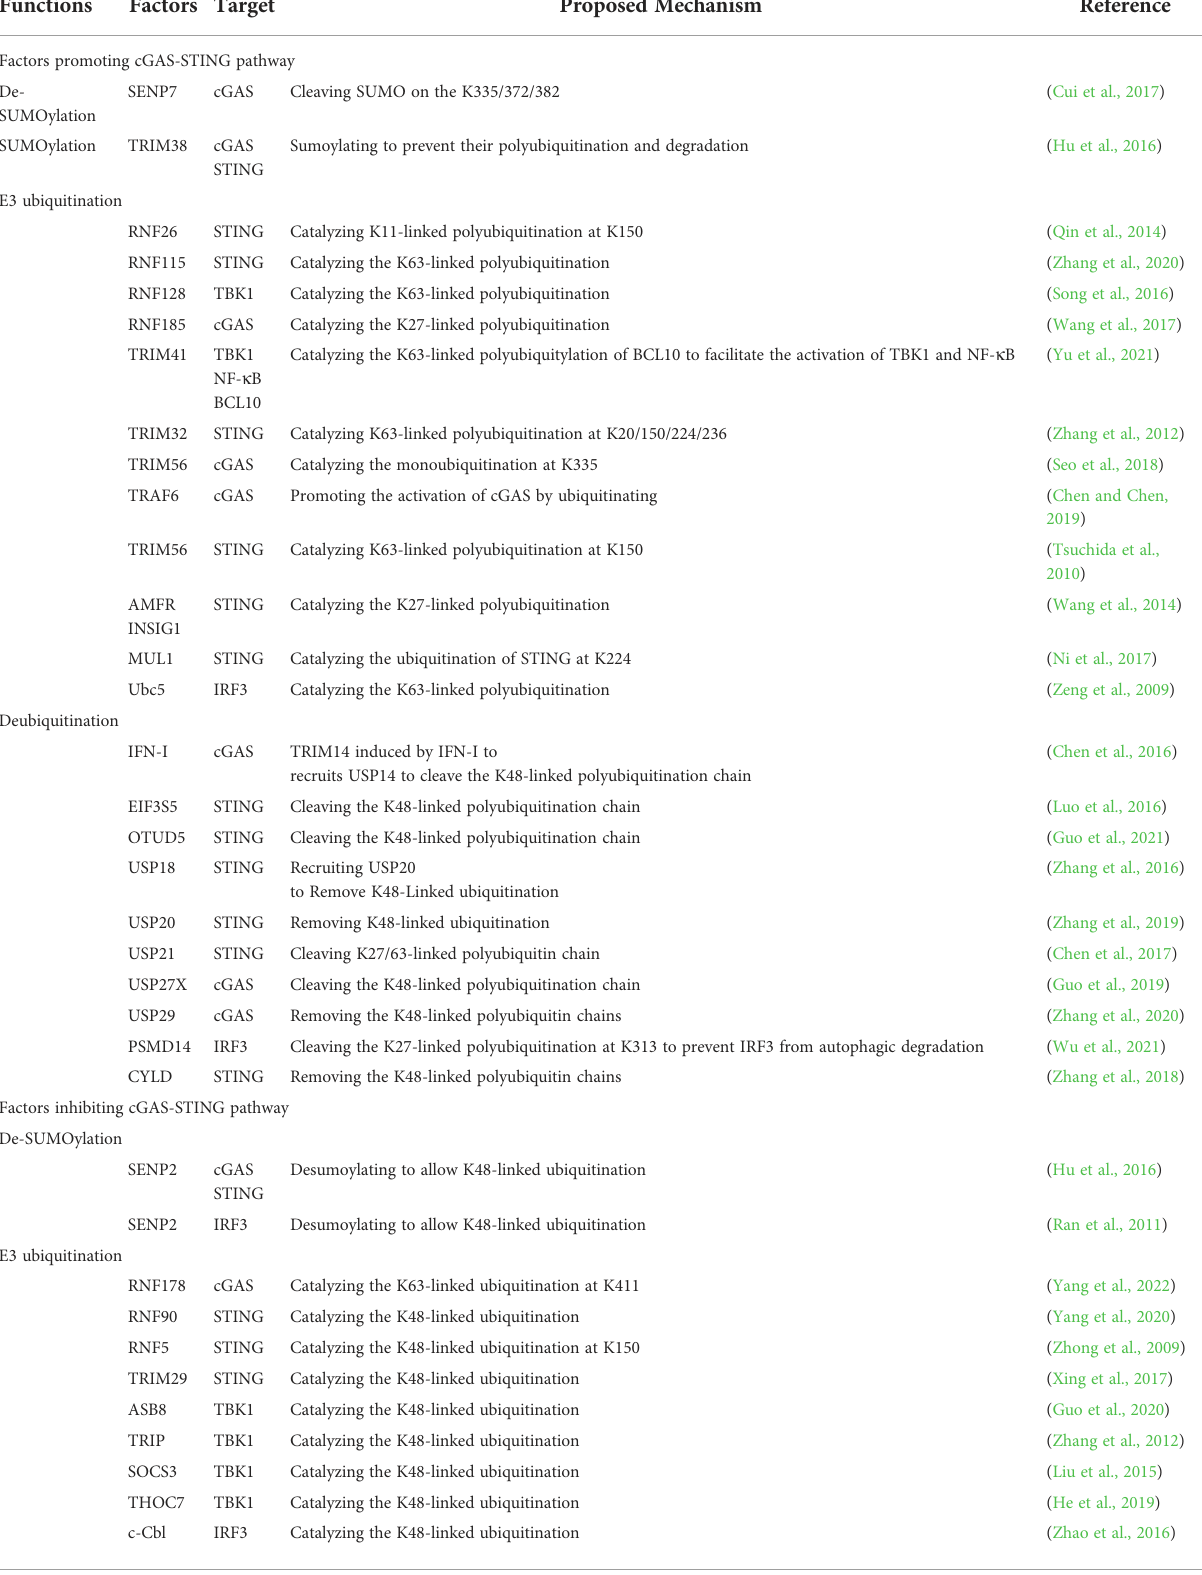
TABLE 1 The regulation of ubiquitination, SUMOylation and expression of key molecules in the cGAS-STING